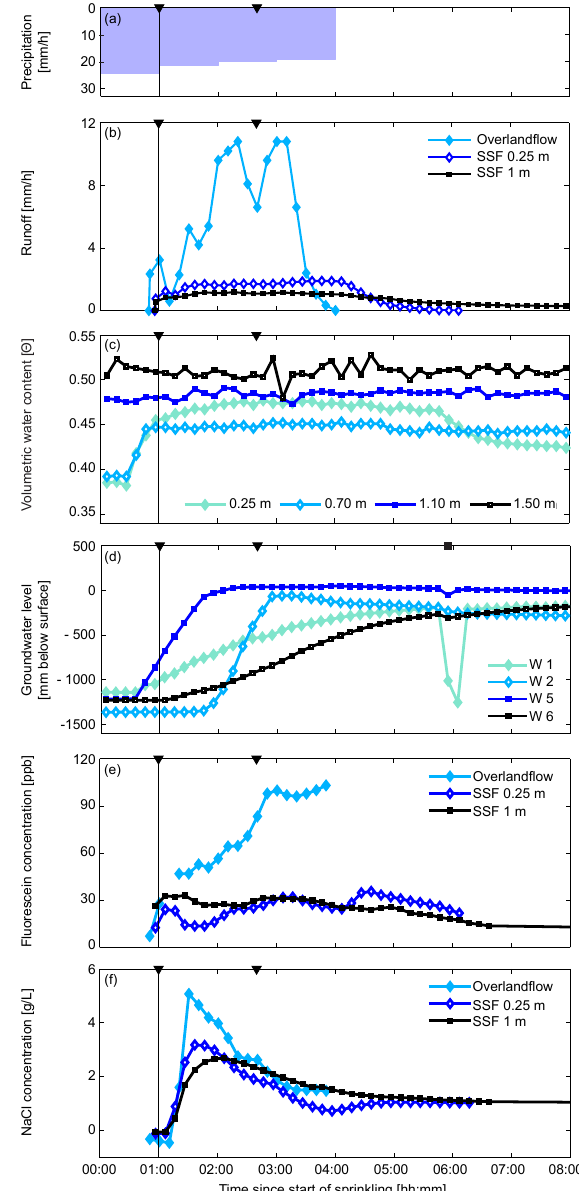
Fig. 5. Second sprinkling experiment on 6 October 2011 at the Ru- Fig. 5 2 nd sprinkling experiment on 06.10.2011 at the Rufiberg’s 10 m x 10 m plot (Fig. 1). 2 fiberg’s 10m × 10m plot (Fig. 1). (a) Precipitation (total artificial (a) Precipitation (total artificial rainfall 83 mm). (b) Runoff in surface flow collector and subsurface 3 rainfall 83mm). (b) Runoff in surface flow collector and subsurface drainage at 0.05, 0.25 and 1.0 m depth (Fig. 1). (c) Volumetric water content measured at TDR nest 4 drainage at 0.05, 0.25 and 1.0m depth (Fig. 1). (c) Volumetric wa- T1. (d) Groundwater dynamics in monitoring wells W1, W2, W5, and W6. (e) Fluorescein tracer 5 ter content measured at TDR nest T1. (d) Groundwater dynamics breakthrough curve and (f) NaCl tracer breakthrough curve in surface flow at 0.05 m depth, shallow 6 in monitoring wells W1, W2, W5, and W6. (e) Fluorescein tracer subsurface flow at 0.25 m depth, and deep subsurface flow at 1.0 m depth. The black triangles ( q ) 7 breakthrough curve and (f) NaCl tracer breakthrough curve in sur- indicate two 5 min irrigation stops for sprinkler cleaning. The black line (|) indicates a change in 8 face flow at 0.05m depth, shallow subsurface flow at 0.25m depth, irrigation intensity from 25 to 20 mm h -1 and the NaCl tracer application. GW grab samples were 9 and deep subsurface flow at 1.0m depth. The black triangles indi- manually taken at all wells approx. 6 h after the start of the sprinkling, indicated in Fig. 5 (d) by a 10 cate two 5min irrigation stops for sprinkler cleaning. The black line black square ( n ). 11 indicates a change in irrigation intensity from 25 to 20mmh − 1 and the NaCl tracer application. GW grab samples were manually taken at all wells approx. 6h after the start of the sprinkling, indicated in (d) by a black